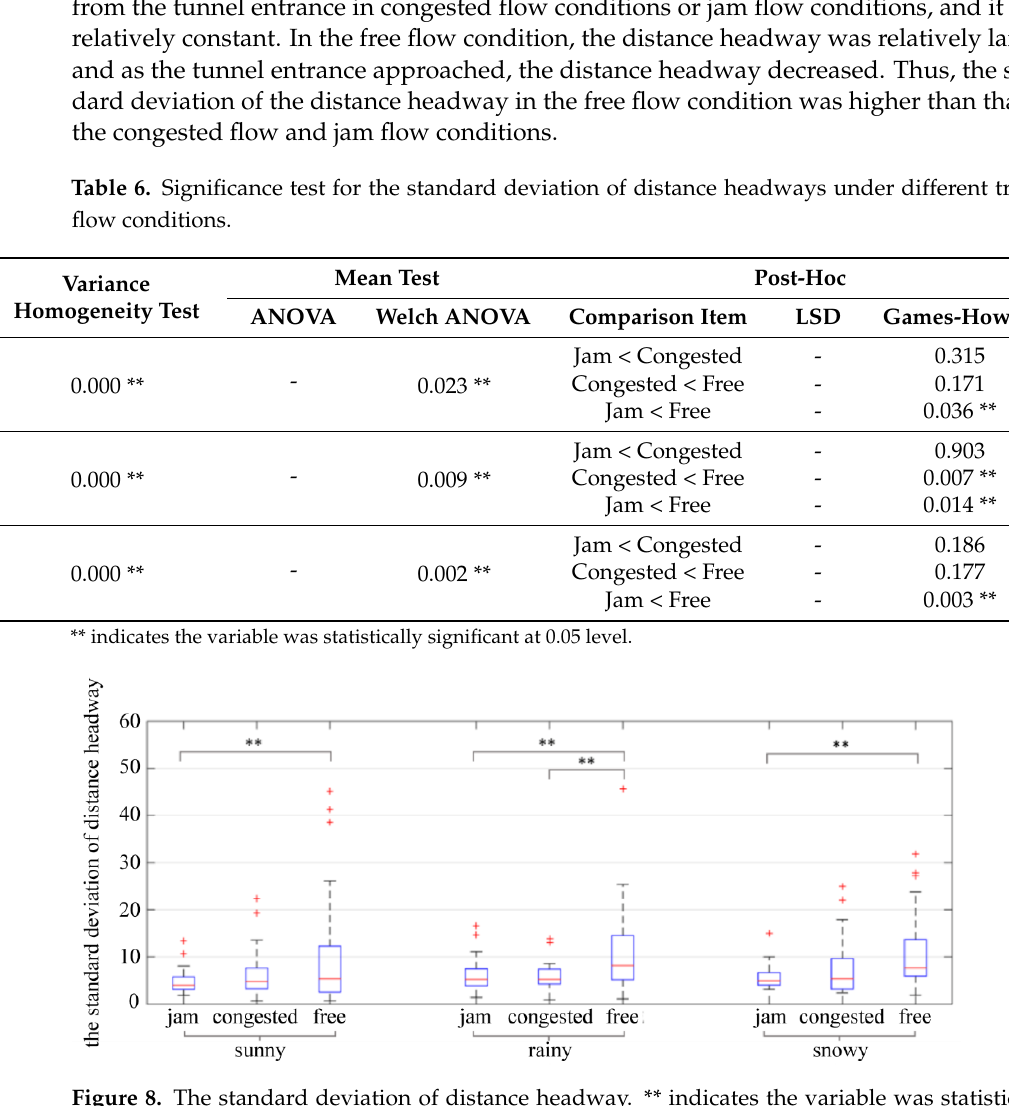
Figure 8. The standard deviation of distance headway. ** indicates the variable was statistically significant at 0.05 level. + indicates outlier.